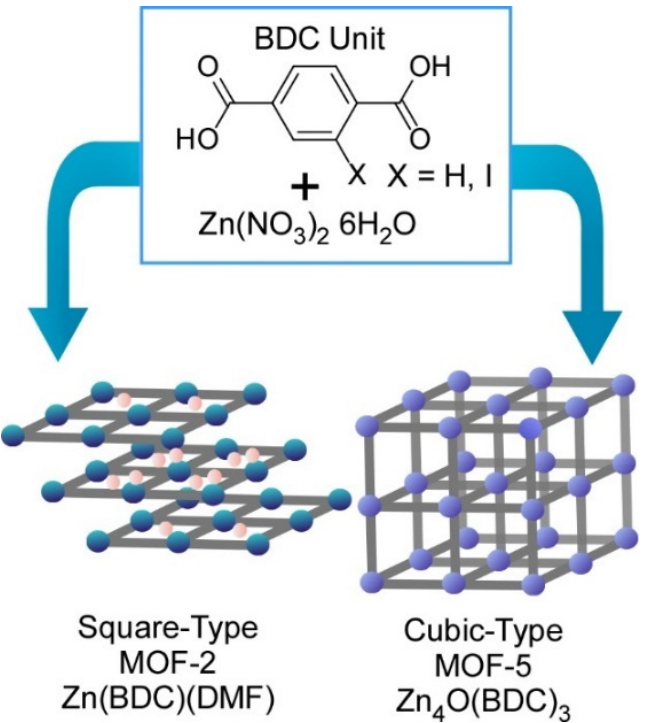
Figure 4. Two MOF structures (MOF-2 and MOF-5) obtained from the same precursors, zinc nitrate and benzene dicarboxylic acid in dimethylformamide under different conditions.